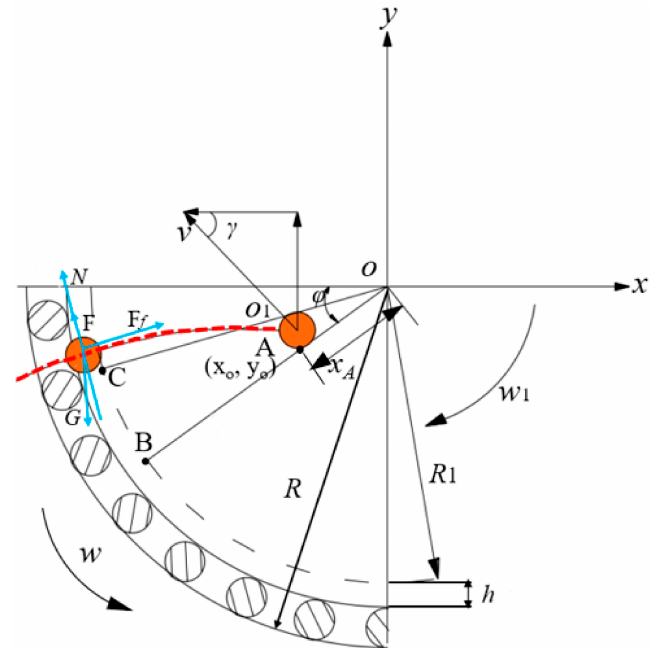
Figure 9. Collision force analysis between the nail teeth and BSF sand. Note: G denotes the self- gravity of the BSFL, N; F f is the frictional force of the BSFL at the end of the spike teeth, N; F represents the effect of the spike teeth on the BSFL when the spike teeth rotated with a high-speed force, N; N is the support force of the spiked teeth on the BSFL, N; w is the angular velocity of the cylinder sieve, rad · s − 1 ; and w 1 is the angular velocity of the spike teeth, rad · s − 1